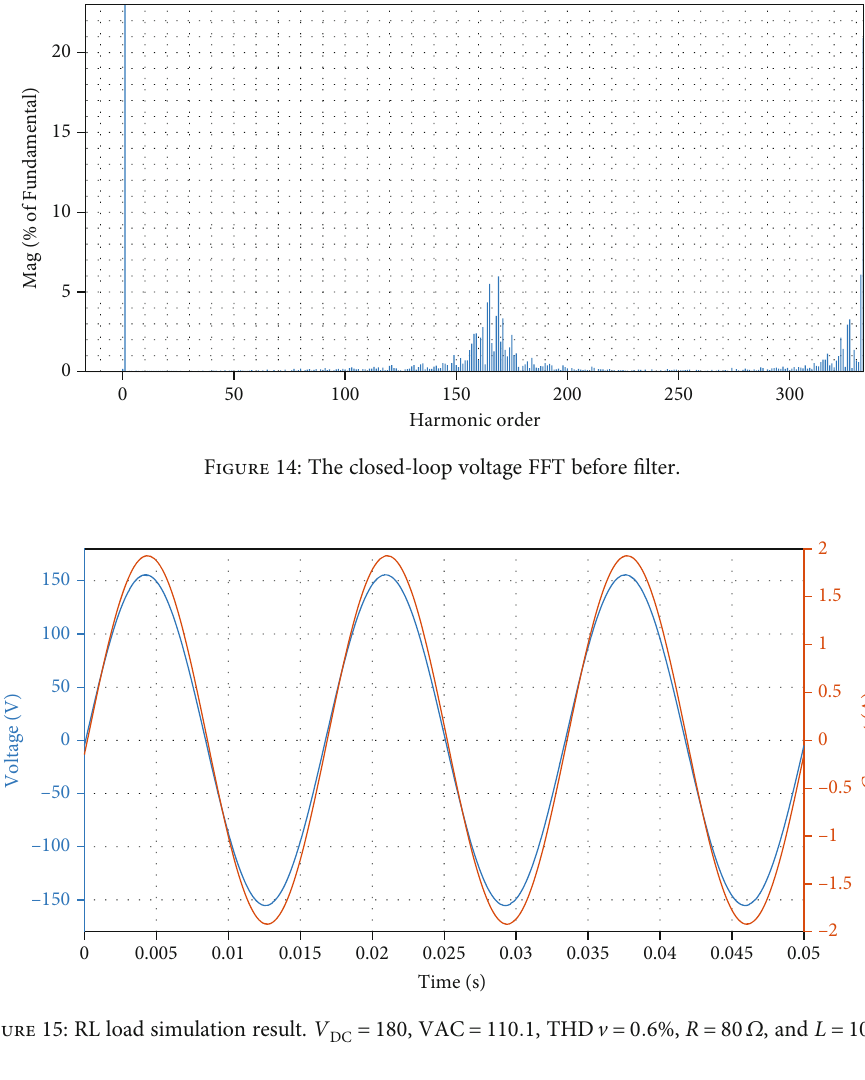
= 180 , VAC = 110 : 1 , THD v = 0 : 6 % , R = 80 Ω , and L = 10mH DC